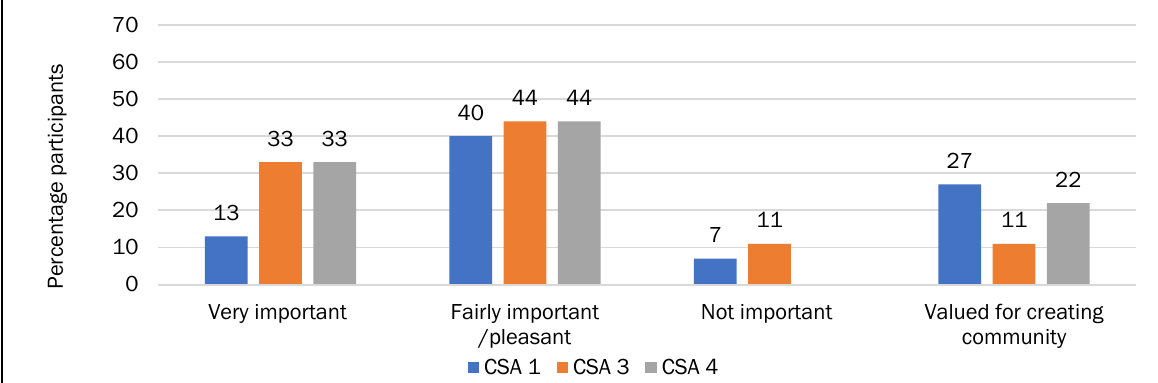
Figure 6. Frequency That CSA Members Were in Contact with Each Other